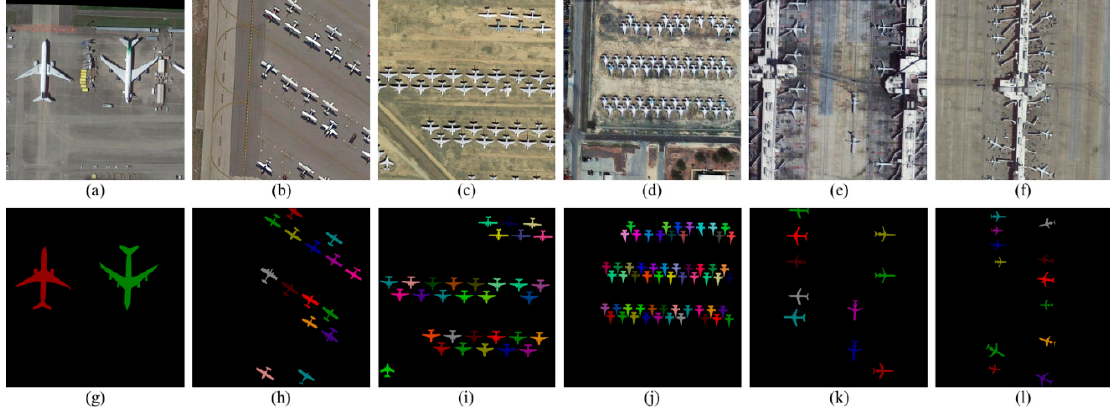
Figure 5. WFA-1400 dataset display. The top row contains six images which are obtained from DOTA. The next column contains corresponding mask image by LabelMe. It colors every aircraft target randomly. ( a – f ) Original Image; ( g – l ) Mask. Table 1. Aircraft size distribution on WFA-1400.